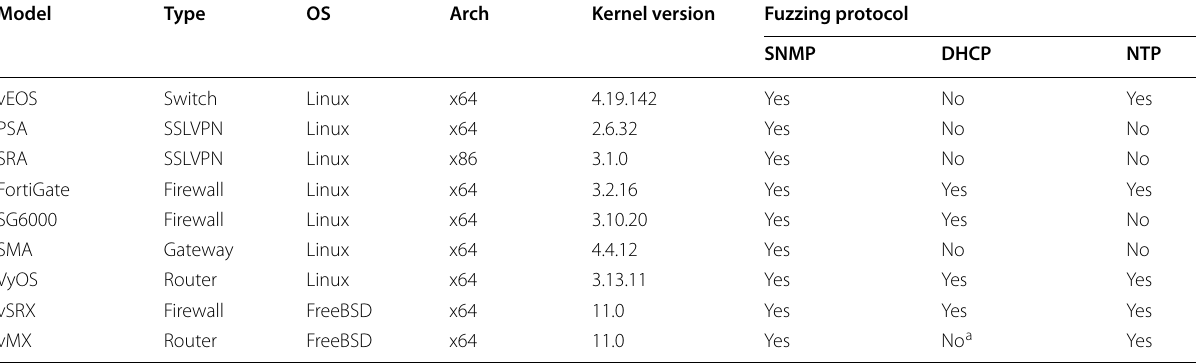
Table 3 Virtualized network devices and services for fuzzing